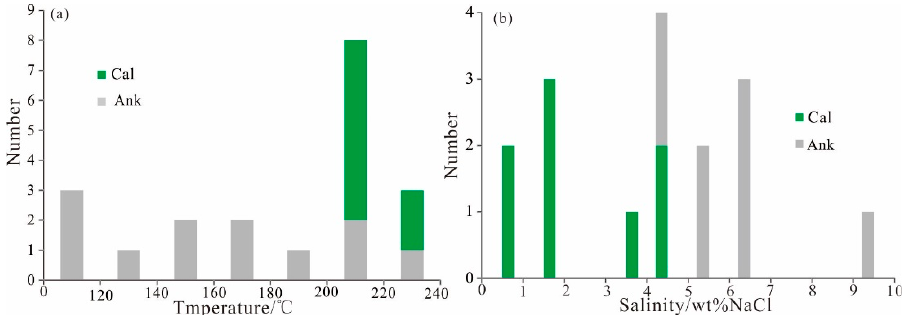
Figure 9. ( a ) Histogram of homogenization temperature values of aqueous inclusions in calcite and ankerite cements. ( b ) Histogram of salinity values of aqueous inclusions in calcite and ankerite ce- ments.